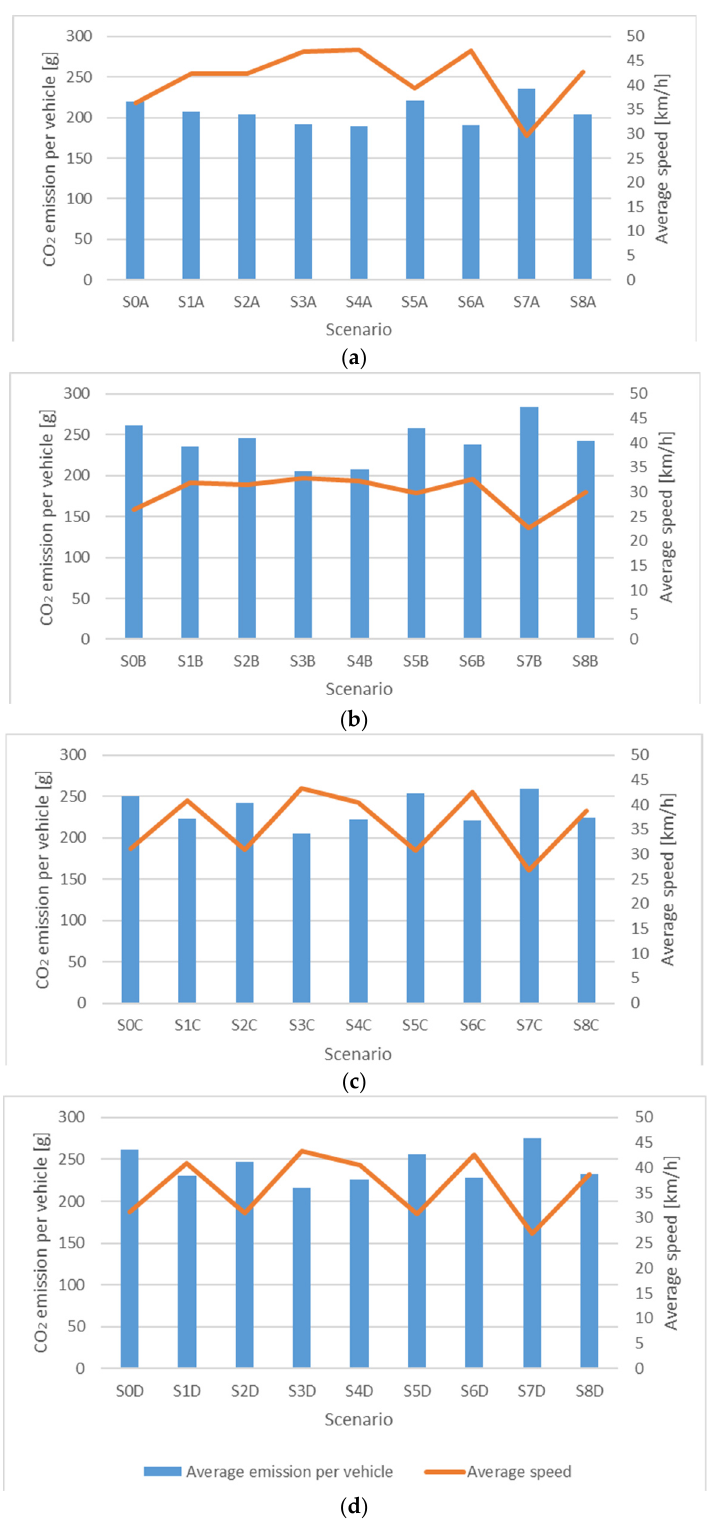
Figure 8. Average estimated CO 2 emissions and average speed in the study area for internal com- bustion engine vehicles, where ( a – d ) represent scenarios